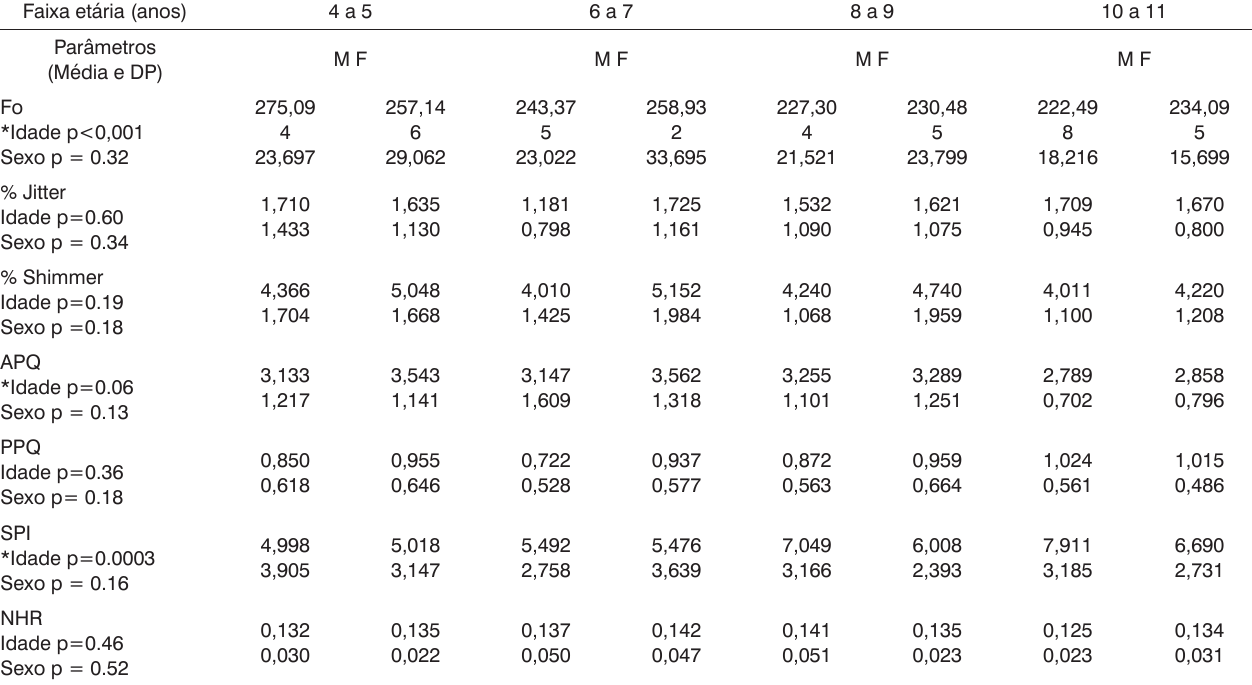
Tabela 1. Média e Desvio padrão dos parâmetros vocais estudados nas diferentes faixas etárias e em ambos os gêneros. Faixa etária